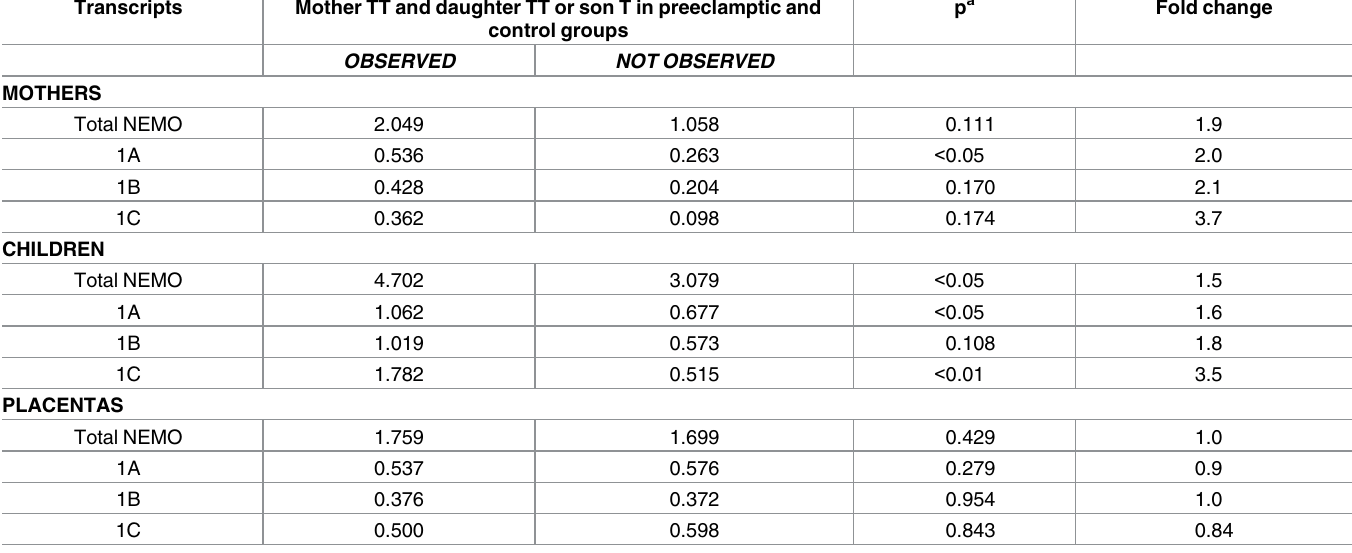
Table 5. Comparison of NEMO gene expression level (Total NEMO and 1A, 1B, 1C transcripts) and simultaneous occurrence of TT genotype in the mother and her child (TT genotype in her daughter or T allele in her